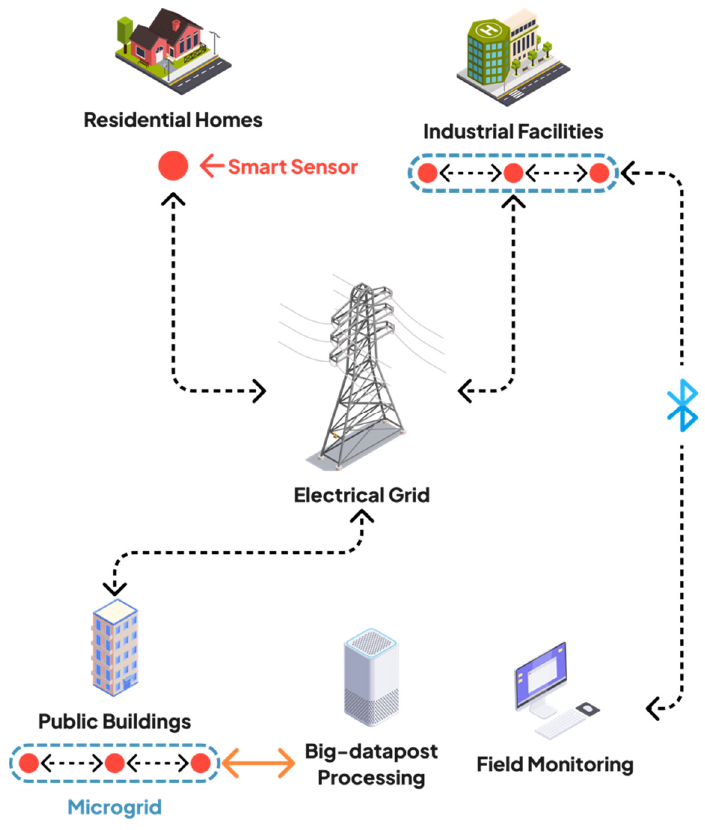
Figure 2. Reprinted from Ref. [13]: Smart sensor in smart-grid system.